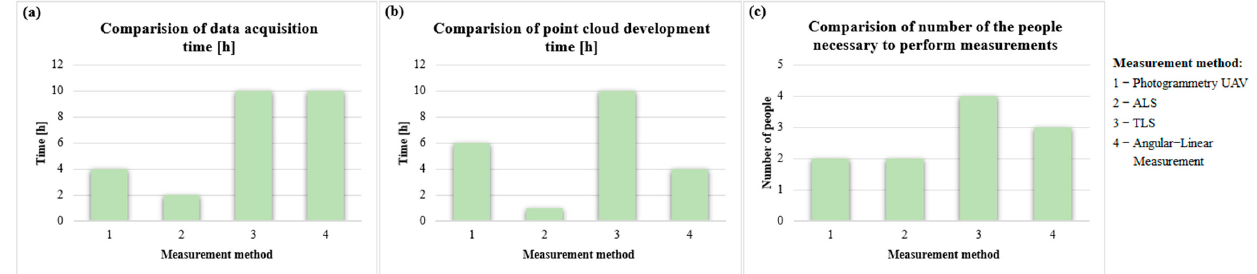
Figure 10. Comparison of the applied methods in terms of ( a ) data acquisition time, ( b ) point cloud development time, and ( c ) the number of people necessary to perform the measurement.